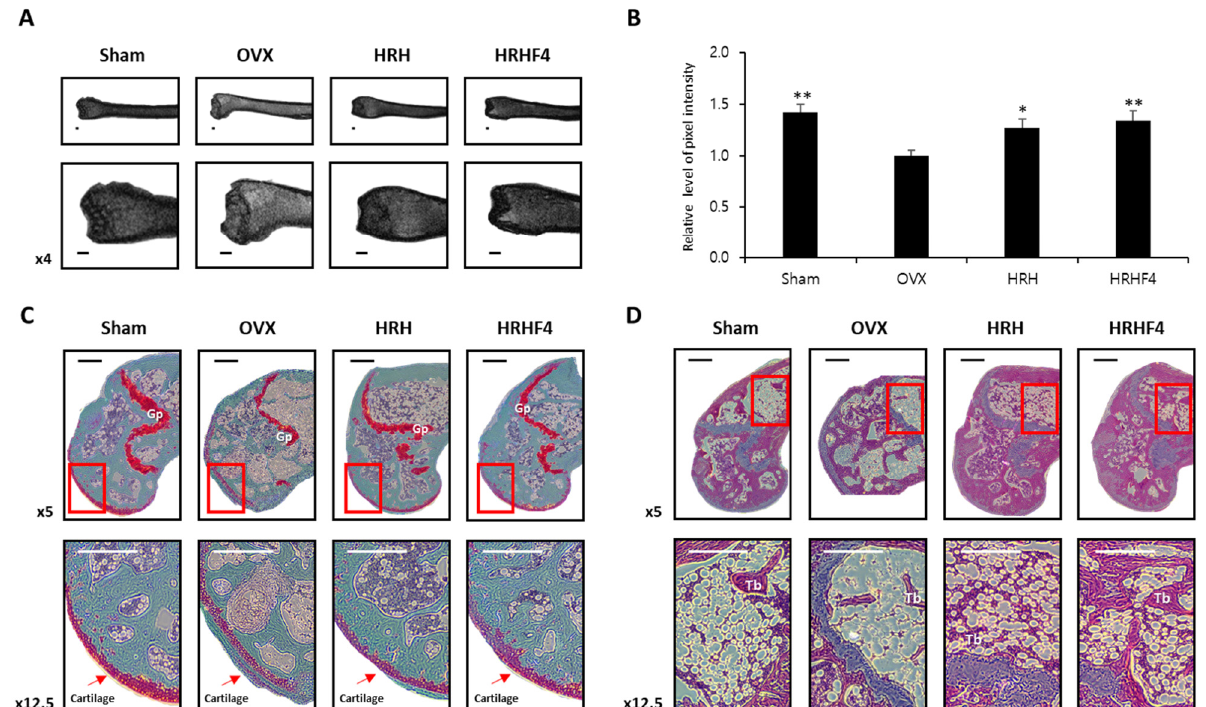
Figure 4. Magnetic-resonance-imaging (MRI) and histological images of the left femur from each mouse group. ( A ) 9.4T MRI. Image data of the left femur of mice from each group. ( B ) Relative level of pixel intensity of the femur captured with MRI images. The pixel intensity shown through MRI results was quantified using the Image J (Java) program. * denoted p < 0.05, ** denotes p < 0.01 vs. OVX control, determined by the least significant difference test. ( C ) Representative histological profiles of the left femur, captured from each mouse group after Safranin O staining. To observe the cartilage of the femur in detail, it was enlarged and captured step by step. ( D ) Representative histological images of the left femur captured from each mouse group after hematoxylin and eosin staining. To observe the femur bone marrow in detail, it was enlarged and captured step by step. OVX, bilateral ovariectomy; HRH, Hexane-soluble fraction from ethanol extract of H. rhamnoides fruits; HRHF4, Hexane-soluble fraction number 4 from ethanol extract of H. rhamnoides fruits; Tb, trabecular bone; Gp, growth plate. Scale bar, 250 µ